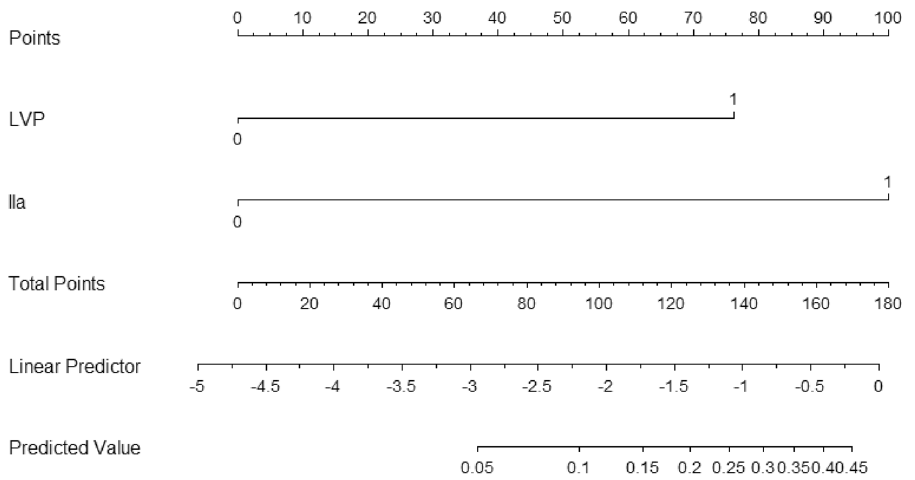
Figure 2. Prognostic nomogram for level IIb